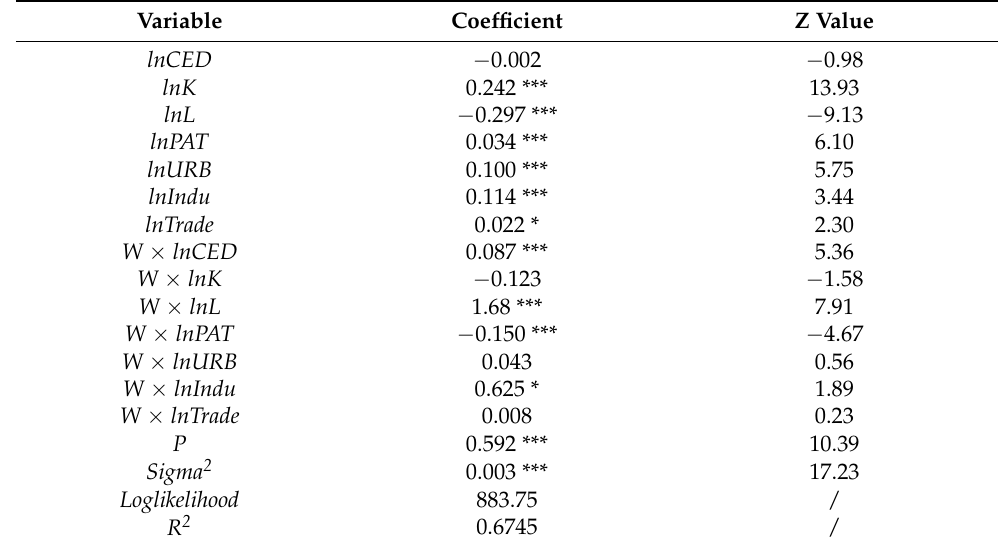
Table 7. The robustness test